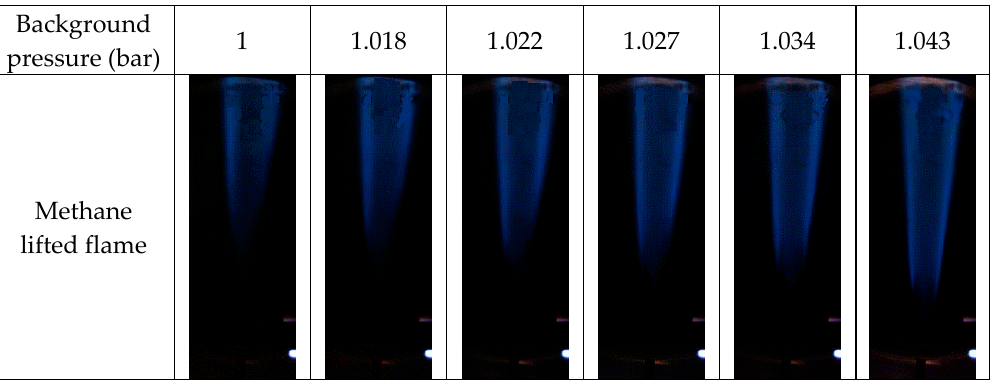
Figure 6. Methane lifted flame at different background pressures (1–1.043 bar).